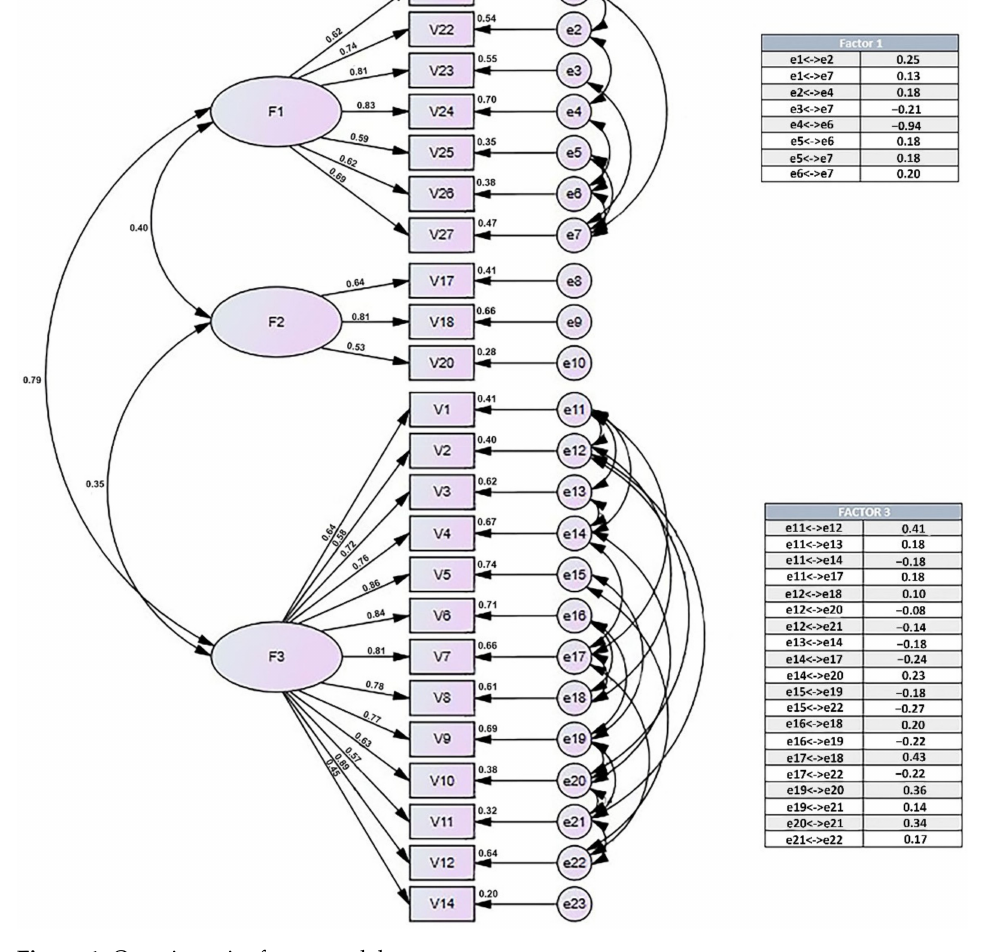
Figure 1. Questionnaire factor model. Figure 1 represents the final structure of the questionnaire composed of 23 items divided into 3 factors, showing from left to right the following values: (1) correlation between factors; (2) standardized regression weights; (3) squared multiple correlations of each variable; and (4) correlations between exogenous variables